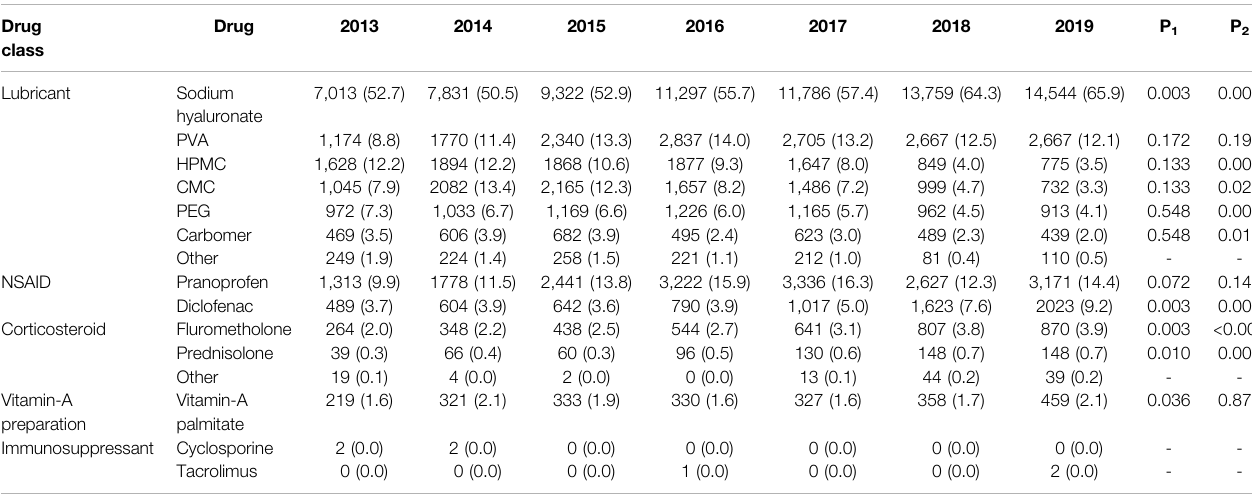
TABLE 2 | Prescription for topical drugs for the treatment of dry eye